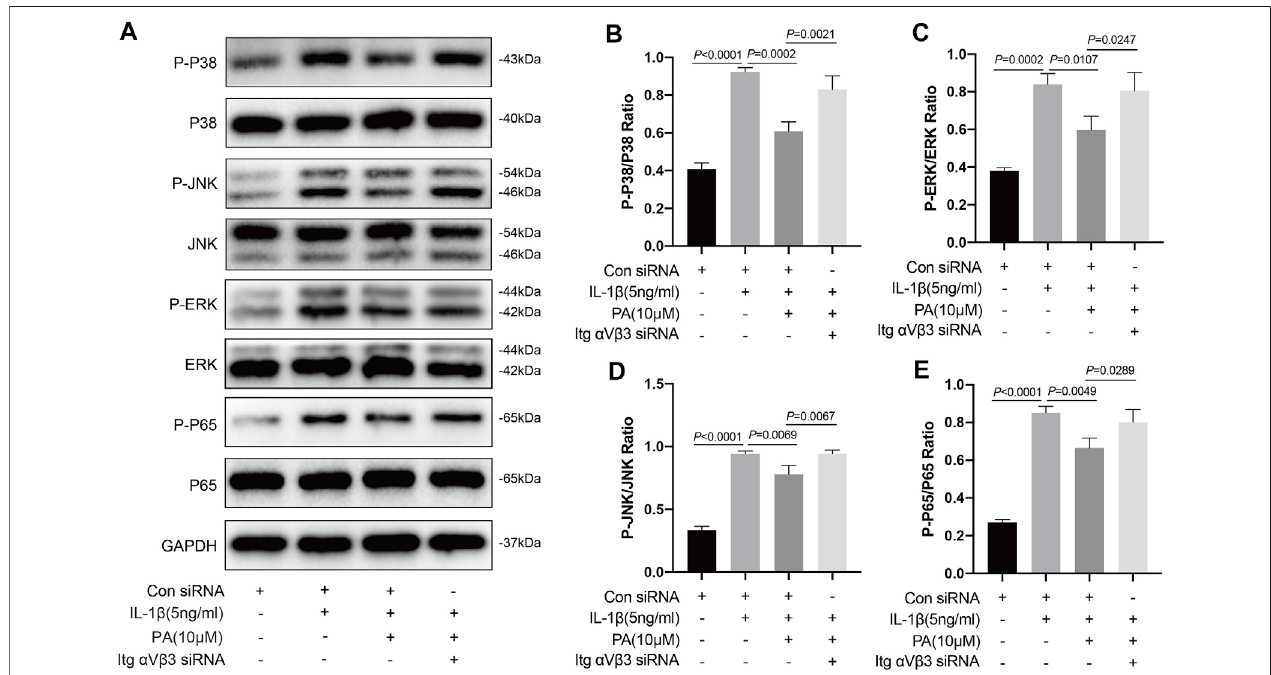
FIGURE7 | Knockdown of integrin α V β 3 reversed the inhibition of MAPK and NF- κ B signaling pathwaysby PA. (A) Westernblotting results and (B – E) quantitative analysis ofMAPK pathway related proteins (P-P38, P38, P-JNK, JNK, P-ERK, and ERK) and NF- κ B pathway related proteins (P-P65, P65) from the Itg α V β 3-de fi ciency micechondrocytesalongwithorwithouttheadministrationof5 ng/mlofIL-1 β and10 μ MofPA.Thenon-phosphorylatedprotein(P38,JNK,ERK,andP65)wasusedas an internal control. Data are presented as means ± SD ( n (cid:1) 3) The exact p value was marked in the corresponding fi gure and p < 0.05 was considered statistically signi fi